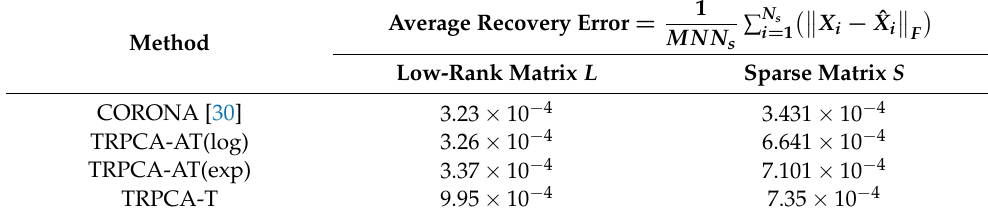
Table 2. Comparison with CORONA [30] for experimental ultrasound imaging data from [30]. CORONA shows slightly better performance compared to the proposed approaches TRPCA-AT(log) and TRPCA-AT(exp) because CORONA is optimized for the structure of the ultrasound data. How- ever, our approaches are not optimized for the structure of the experimental ultrasound data.